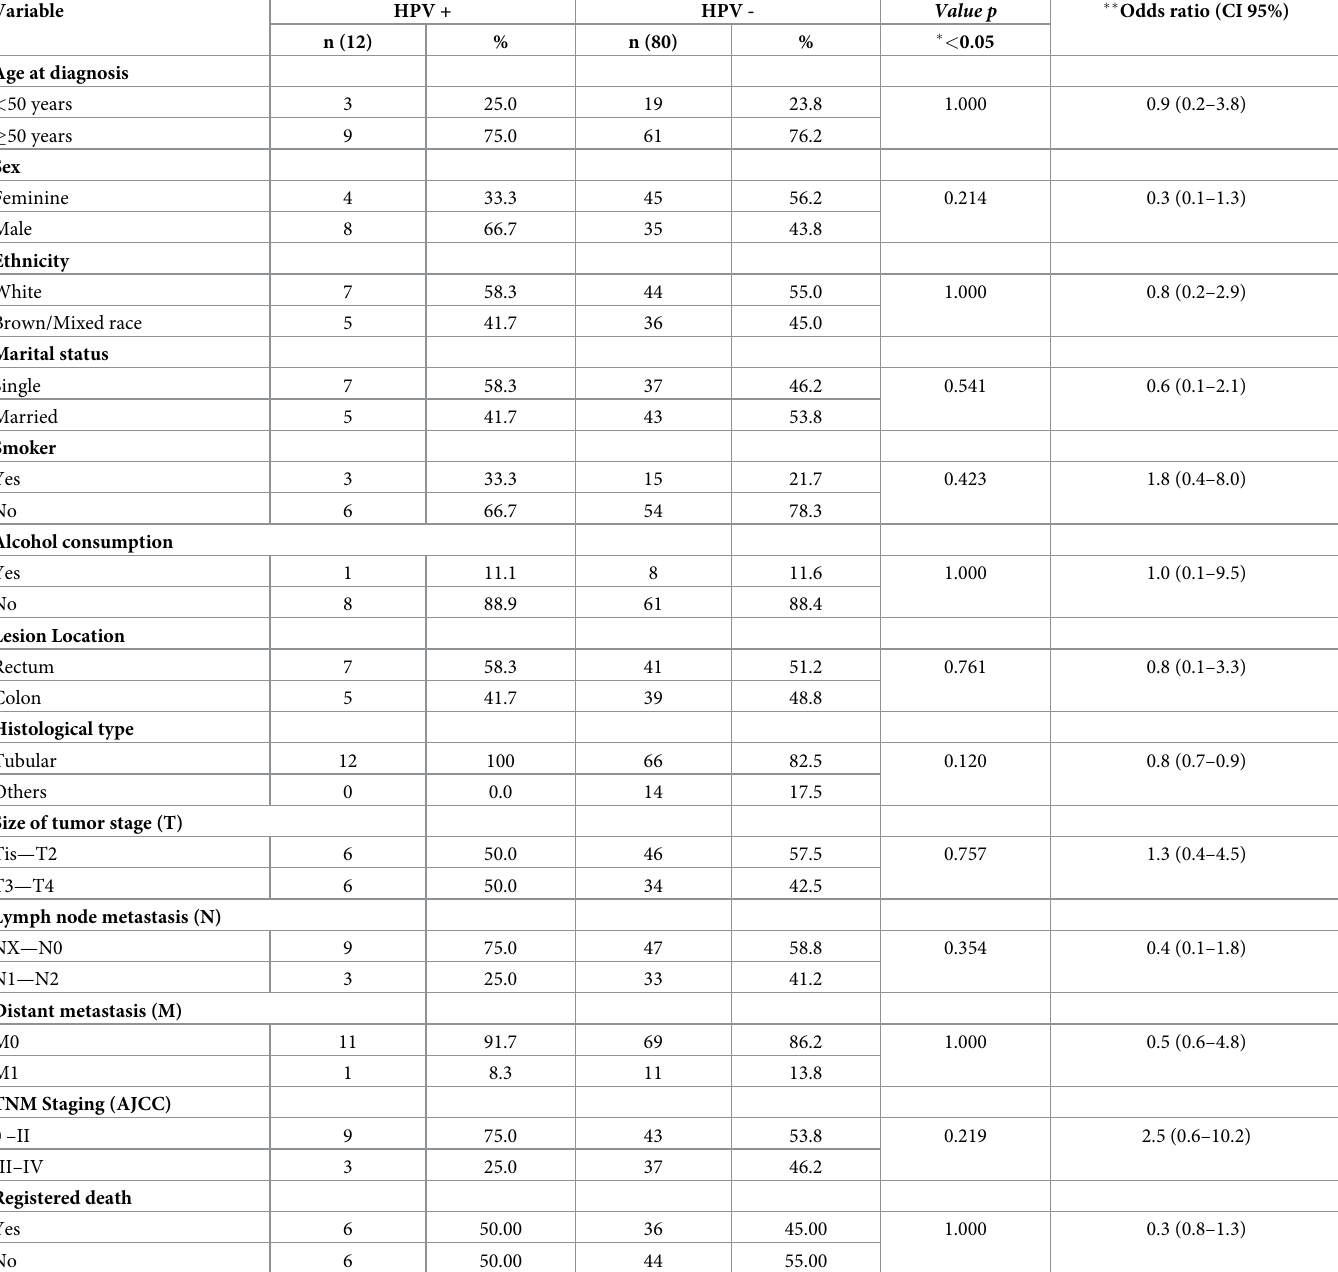
Table 2. Univariate analysis of presence of HPV associated with the sociodemographic aspects and the clinicopathological in participants diagnosed with colorectal